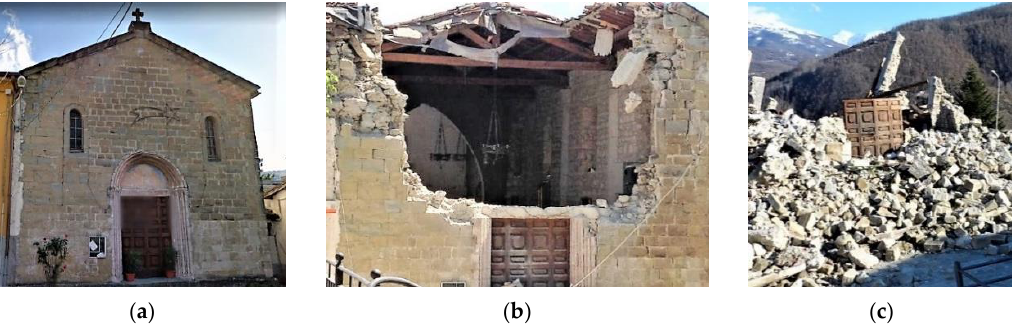
Figure 10. The St. Lawrence and St. Paul Church in Accumoli: ( a ) before the Central Italy earthquake; ( b ) after the 24 August strong motion; and ( c ) after the earthquake occurred on 30 October 2016.